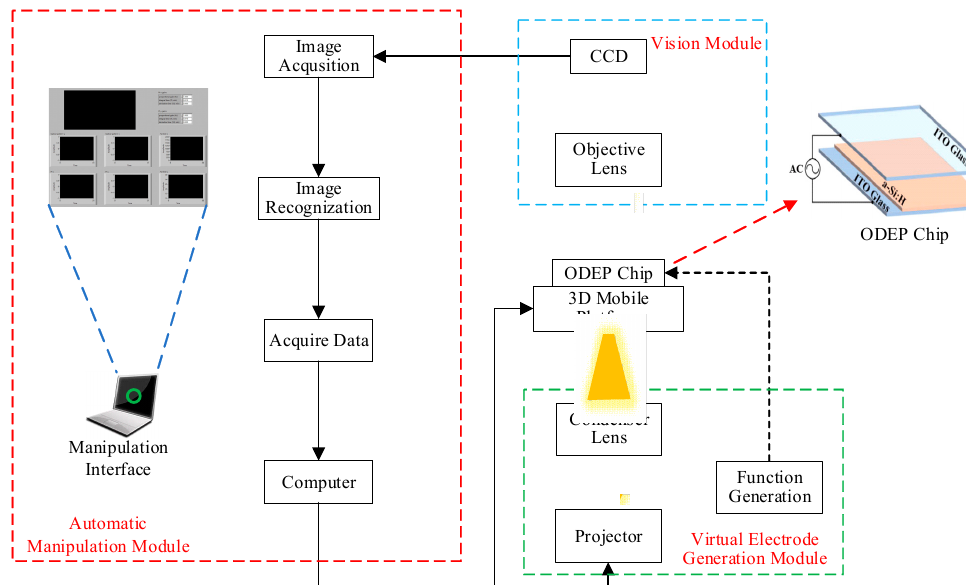
Figure 1. Schematic of the experimental system.